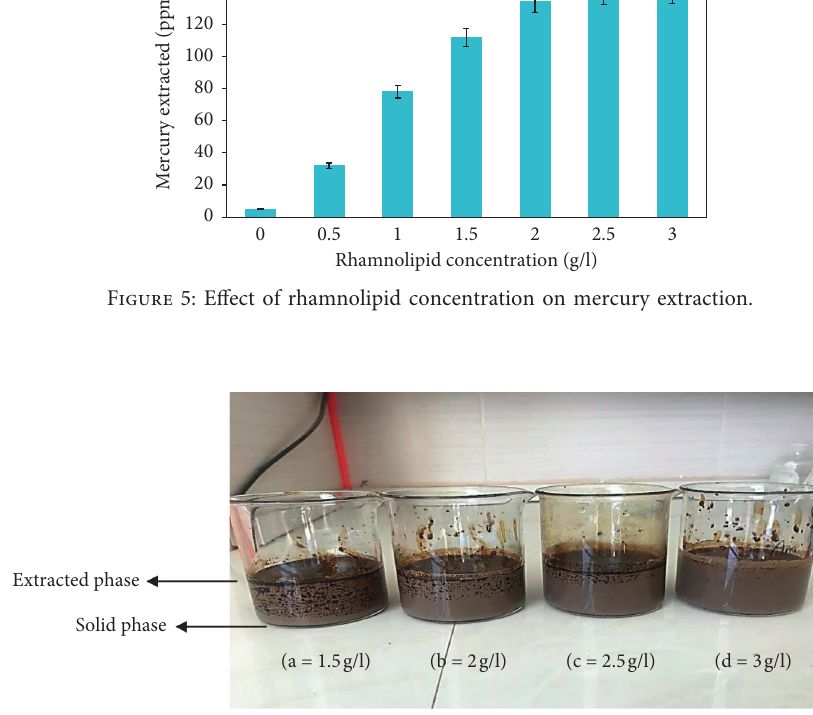
Figure 6: Extracted and solid phase during the metal removing process (rpm � 200, T � 25 ° C).